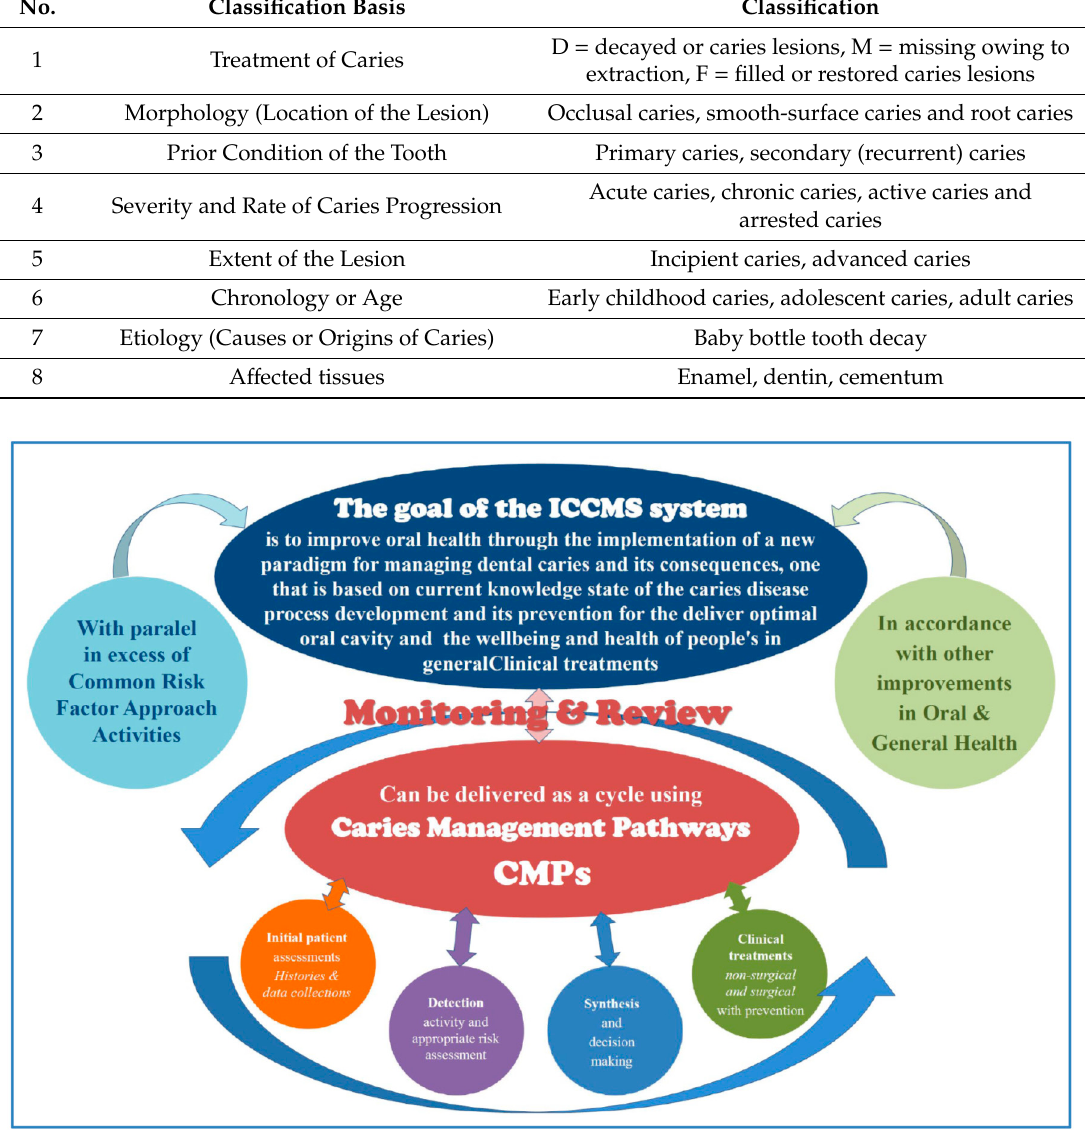
Table 1. Principal carious lesion classification criteria. Figure 7. Scheme of the so-called caries continuum with codes from the ICDAS system.